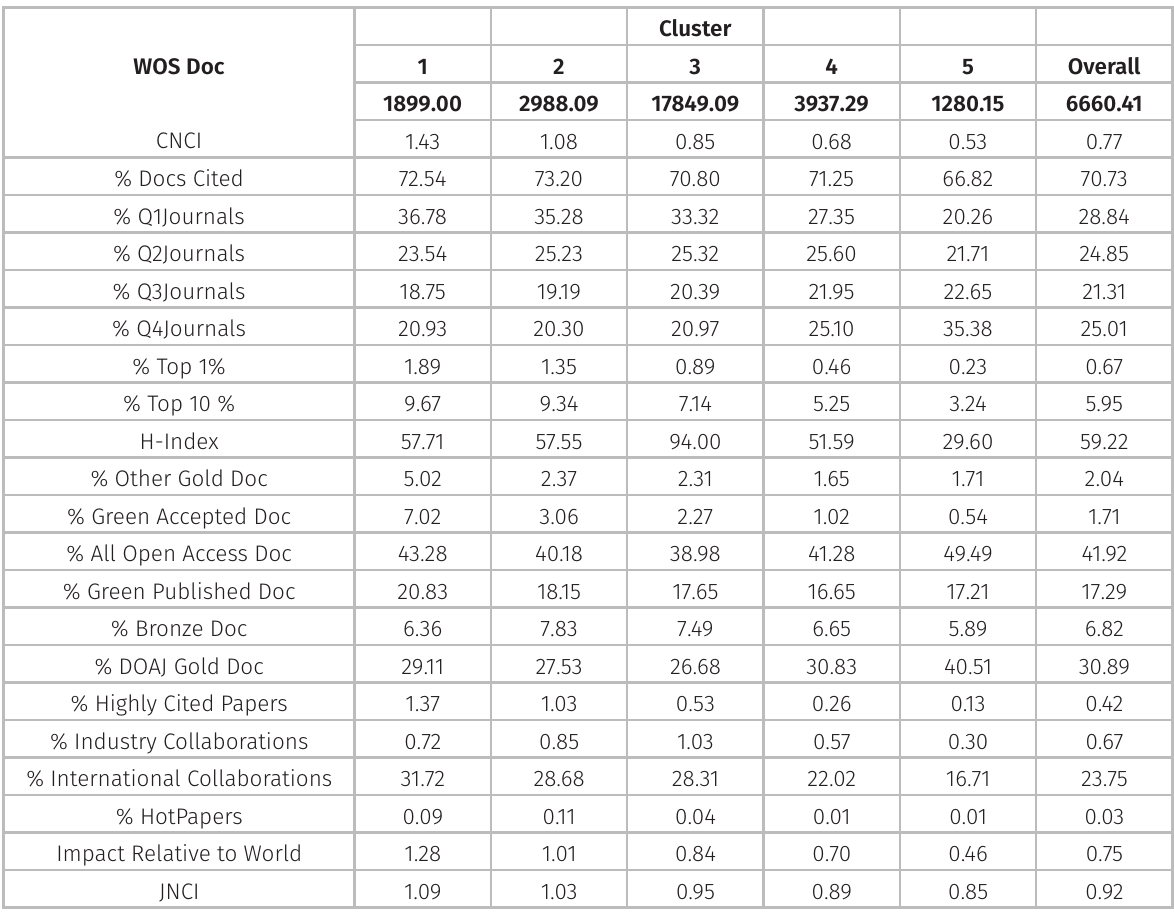
Table V. Average performance per Higher Education Institute